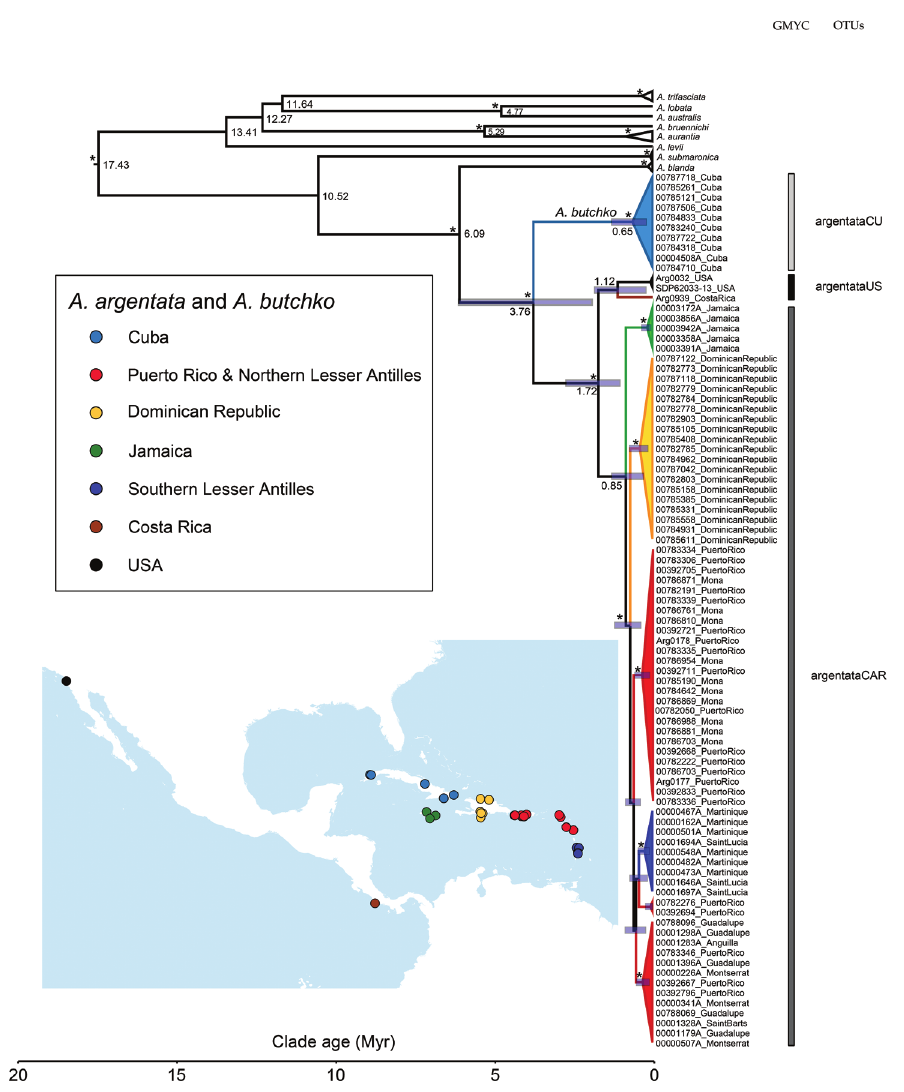
Figure 1. A dated phylogeny of Argiope argentata in the Caribbean, and other Argiope relatives. Shown are the results of tree based species delimitation analyses (GMYC method) on a BEAST phylogeny (node ages in million years) and the location of spiders used in this study (inset picture). Asterisk denotes posterior probability support >95%. The OTUs (operational taxonomic units) correspond to a cryptic species, Argiope butchko sp. n., from Cuba (argentataCU) and populations from other Caribbean islands (argentataCAR) plus mainland (argentataUS) treated as conspecific ( A. argentata ). (Darriba et al. 2012). We employed a Bayesian approach to phylogenetic reconstruc- tion implemented in MrBayes 3.1.2 (Ronquist et al. 2012). Two independent runs, each with four Markov chain Monte Carlo (MCMC) chains, were performed